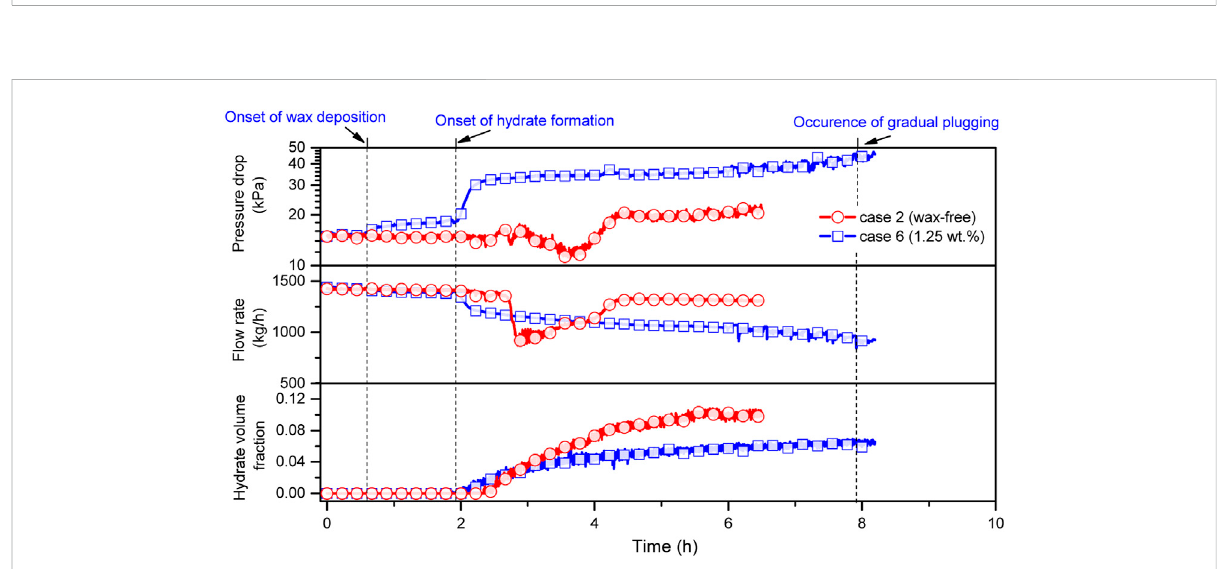
FIGURE 6 Variation trend of pressure drop, fl ow rate, and hydrate volume fraction of case 2 and 6 versus